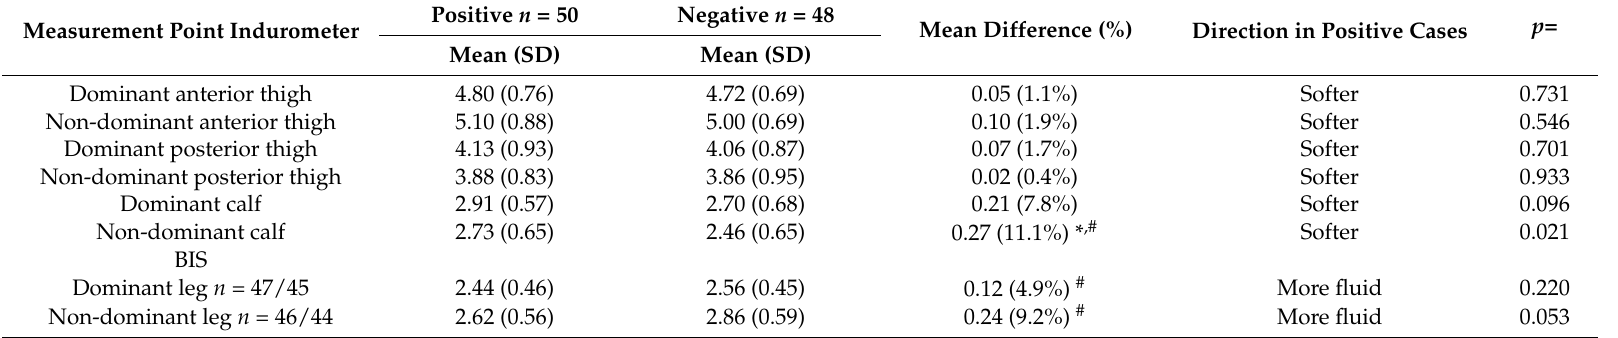
Table 2. Between-infection group differences for Indurometer and BIS measures, size, and direction of